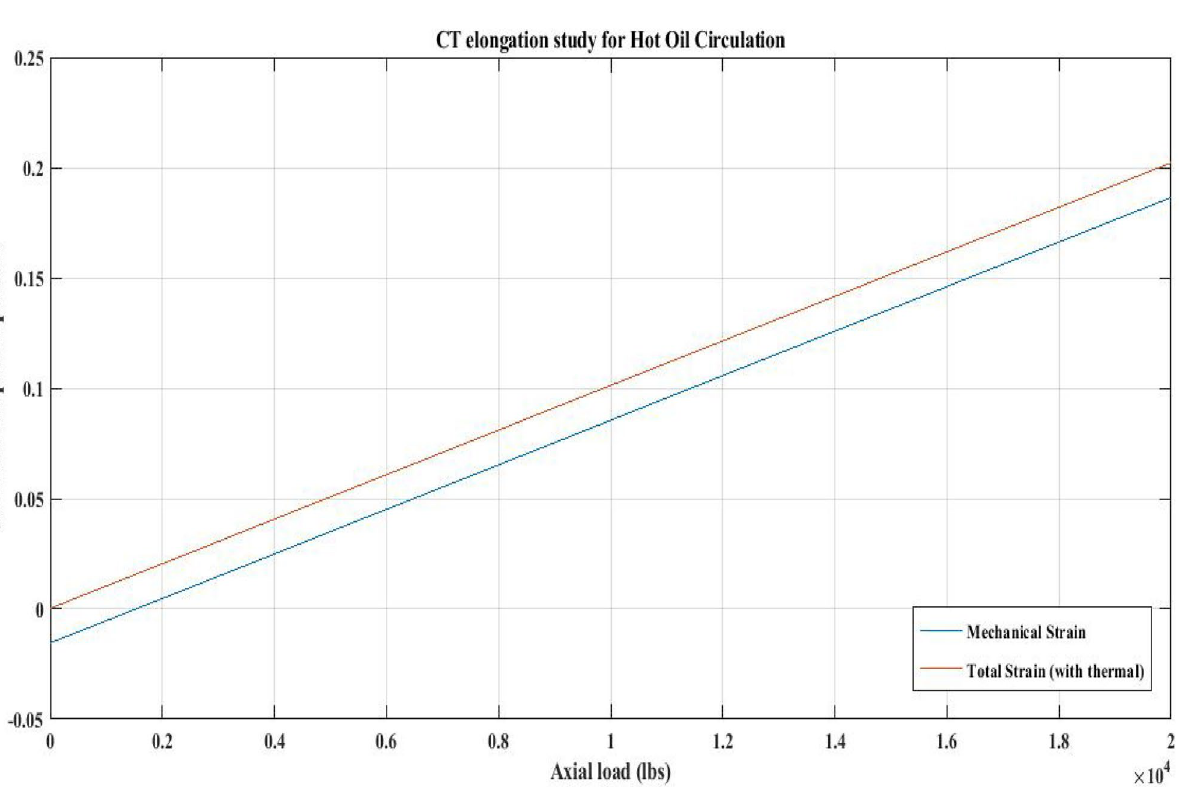
Figure 31. CT strain plot for a HOC job with